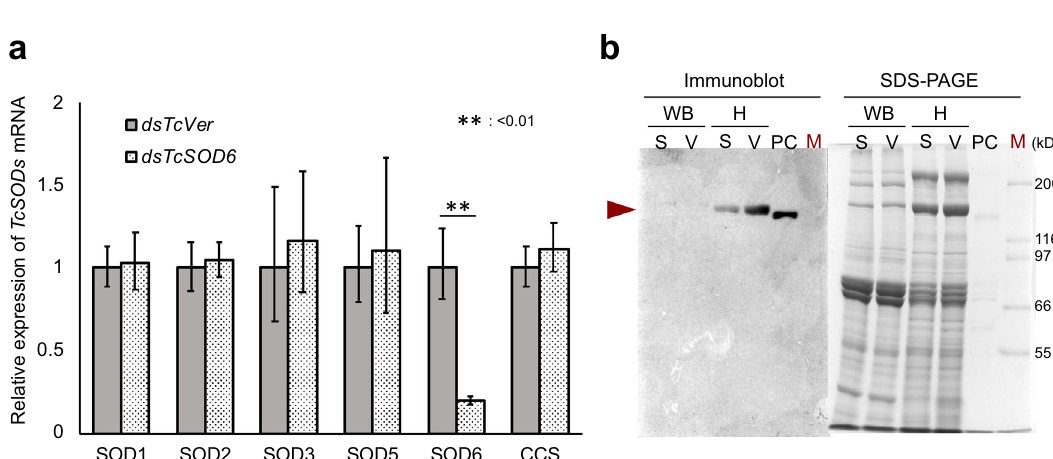
Figure 4. Verification of the expression of TcSOD6 mRNA and protein after the knockdown of TcSOD6 . ( a ) Verification of the mRNA expression levels of TcSODs by qRT–PCR in TcSOD6 knockdown- T. castaneum . Whole bodies subjected to TcSOD6- and TcVer- knockdown (n = 3, respectively) were used for RT–qPCR. RQ values of TcVer - and TcSOD6 -knockdown pupae. The bar charts represent the mean RQ value. The error bars represent the relative minimum / maximum expression levels relative to the mean RQ value. ( b ) Immunoblot analysis of TcSOD6 proteins. Proteins in pupal whole body lysates (WB) and haemolymph (H) were separated by SDS–PAGE and then analysed by immunoblotting using an antibody against the TcSOD6 protein. The TcSOD6 protein band was detected at ~ 130 kDa, as indicated by the arrowhead. Lanes labelled (M) include molecular weight standard proteins. (S) indicates ds TcSOD6 ; (V) indicates ds TcVer ; (PC) indicates the recombinant TcSOD6 protein (0.55 μg/lane) used as a positive control. Full-length blots/gels are presented in Supplementary Fig.